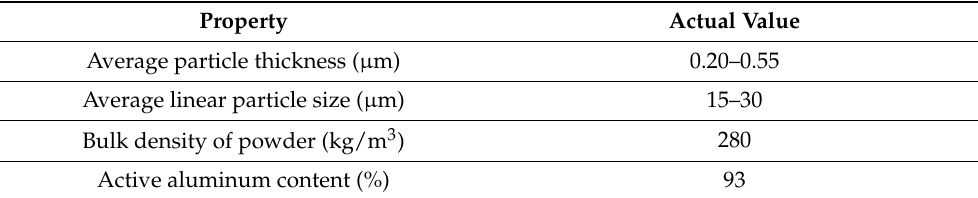
Table 7. Characteristics of aluminum powder.